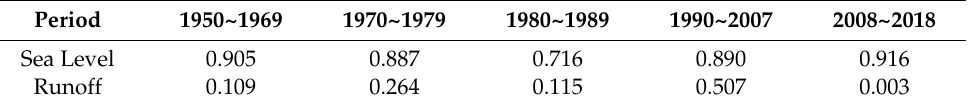
Table 3. Pearson correlation coefficients between tidal asymmetry and sea level or runoff.